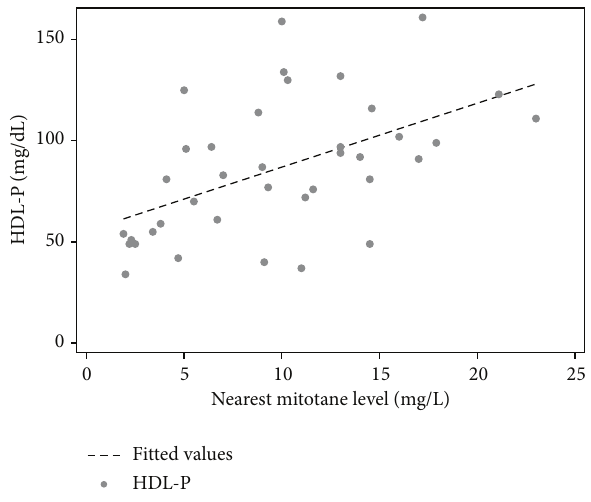
Figure 2: Scatter plot illustrating the relationship between peak HDL-c during mitotane therapy (HDL-P) and mitotane concentra- tions ( 𝑟 = 0.52 and 𝑃 = 0.007 ) in 38 patients with adrenocortical